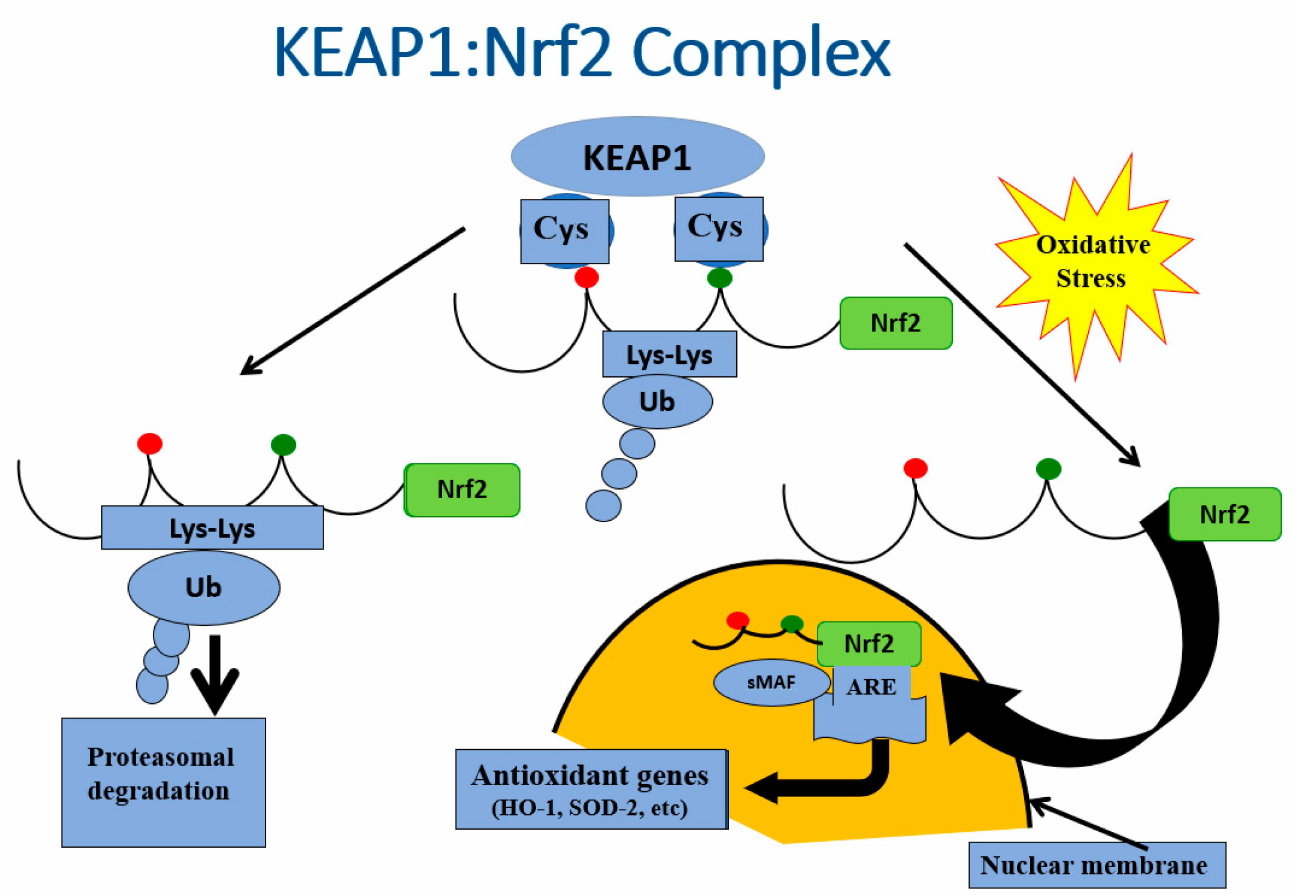
Figure 6. Illustration of the functional relationships between KEAP1 and Nrf2 under conditions of non-stress and oxidative stress. Under quiescent conditions, Nrf2 is bound by KEAP1 in the cytoplasm, which ushers Nrf2 to proteosomes for degradation. In the face of oxidative stress, Nrf2 is released from KEAP1 and enters the nucleus, where it serves as a key activator for the promoter of antioxidant